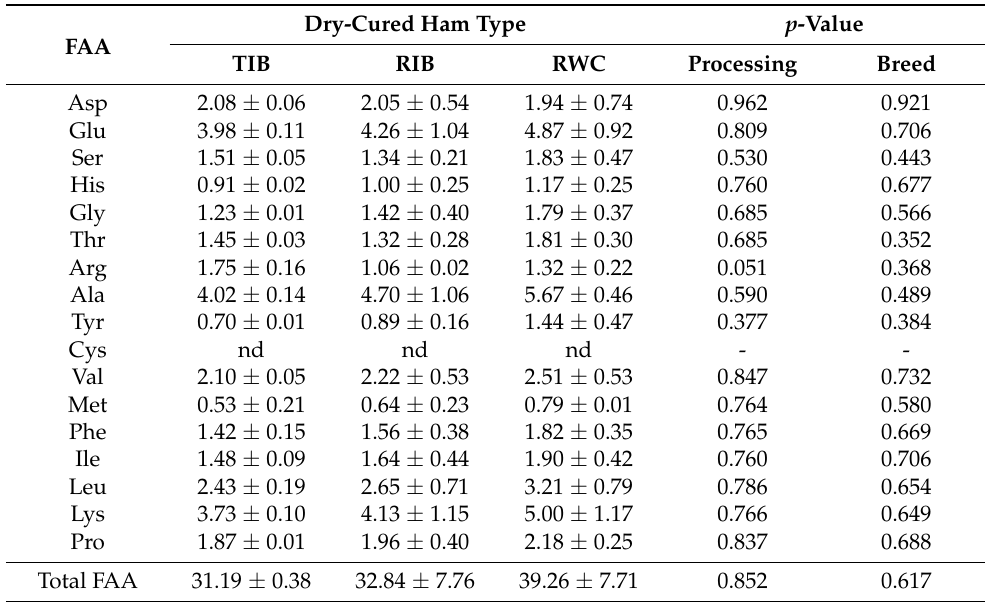
Table 3. Effect of Iberian dry-cured ham type (processing) and effect of breed on free amino acid content (FAA). The results are expressed in g/kg of dry matter as mean values ± SEM.